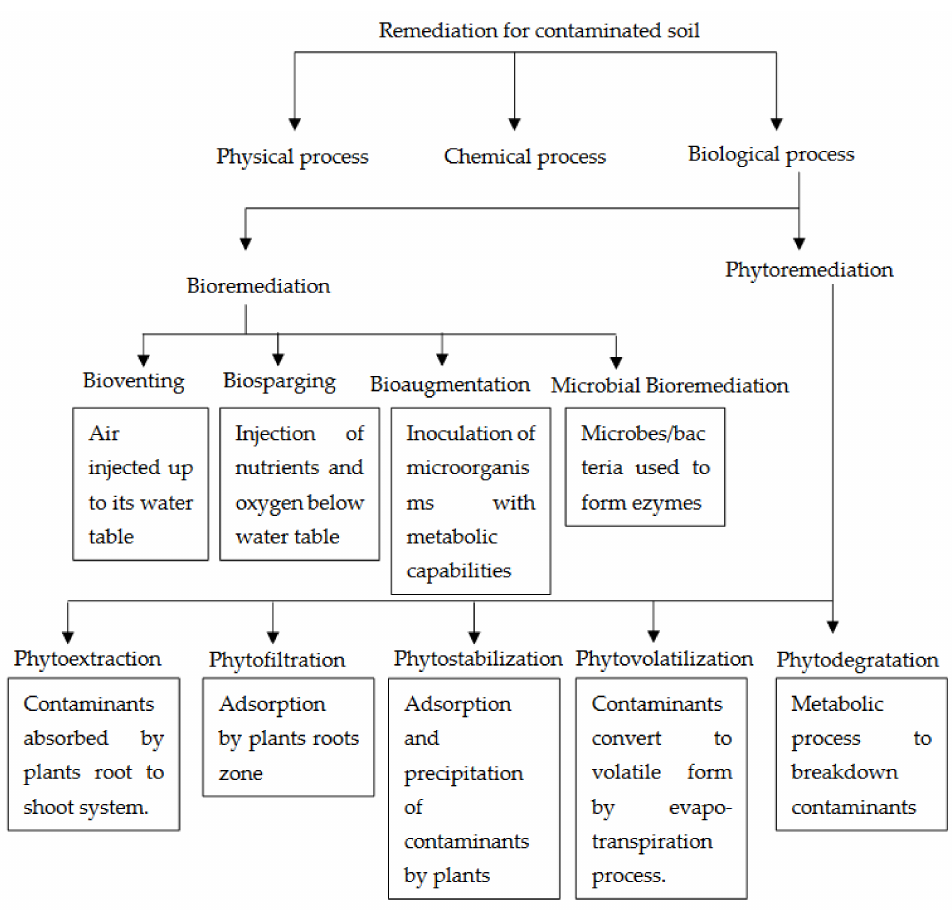
Figure 1. Remediation techniques